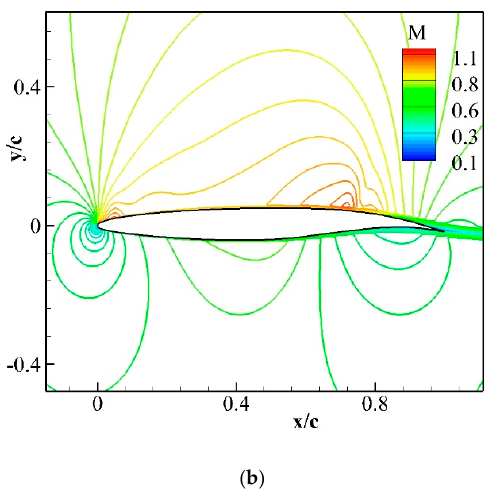
Figure 16. Computed ( a ) coefficient of pressure and ( b ) Mach contours for flow over the VCCTEF123 airfoil at a zero angle of attack.